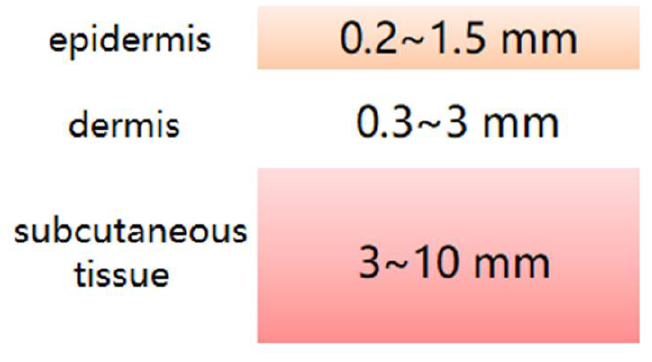
Figure 2. Human tissue depth model.